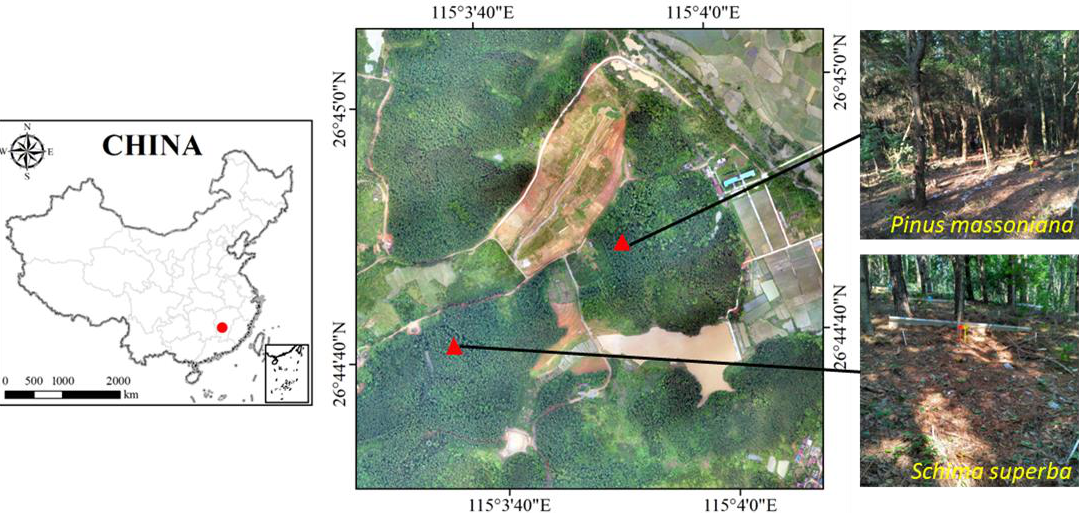
Figure 1. Location of the study area and sampling sites in the Pinus massoniana and Schima superba plantations.